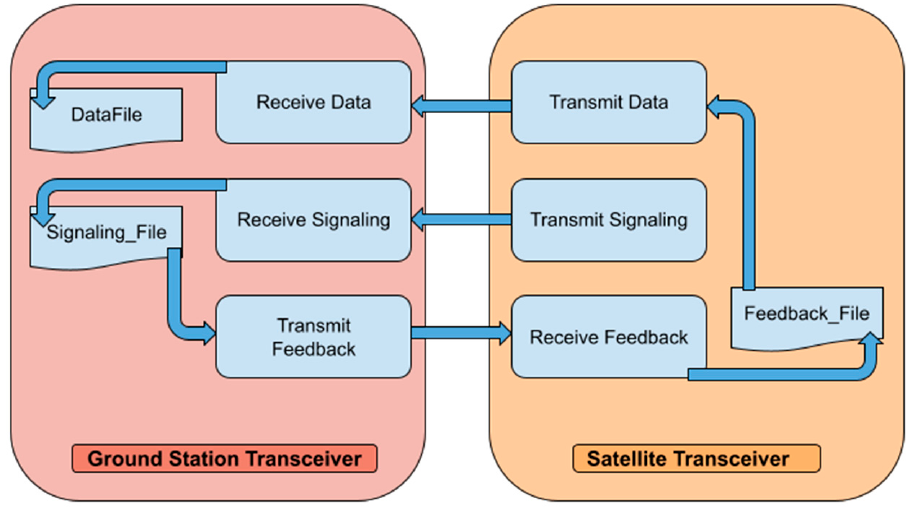
Figure 3. Information flow within the system.